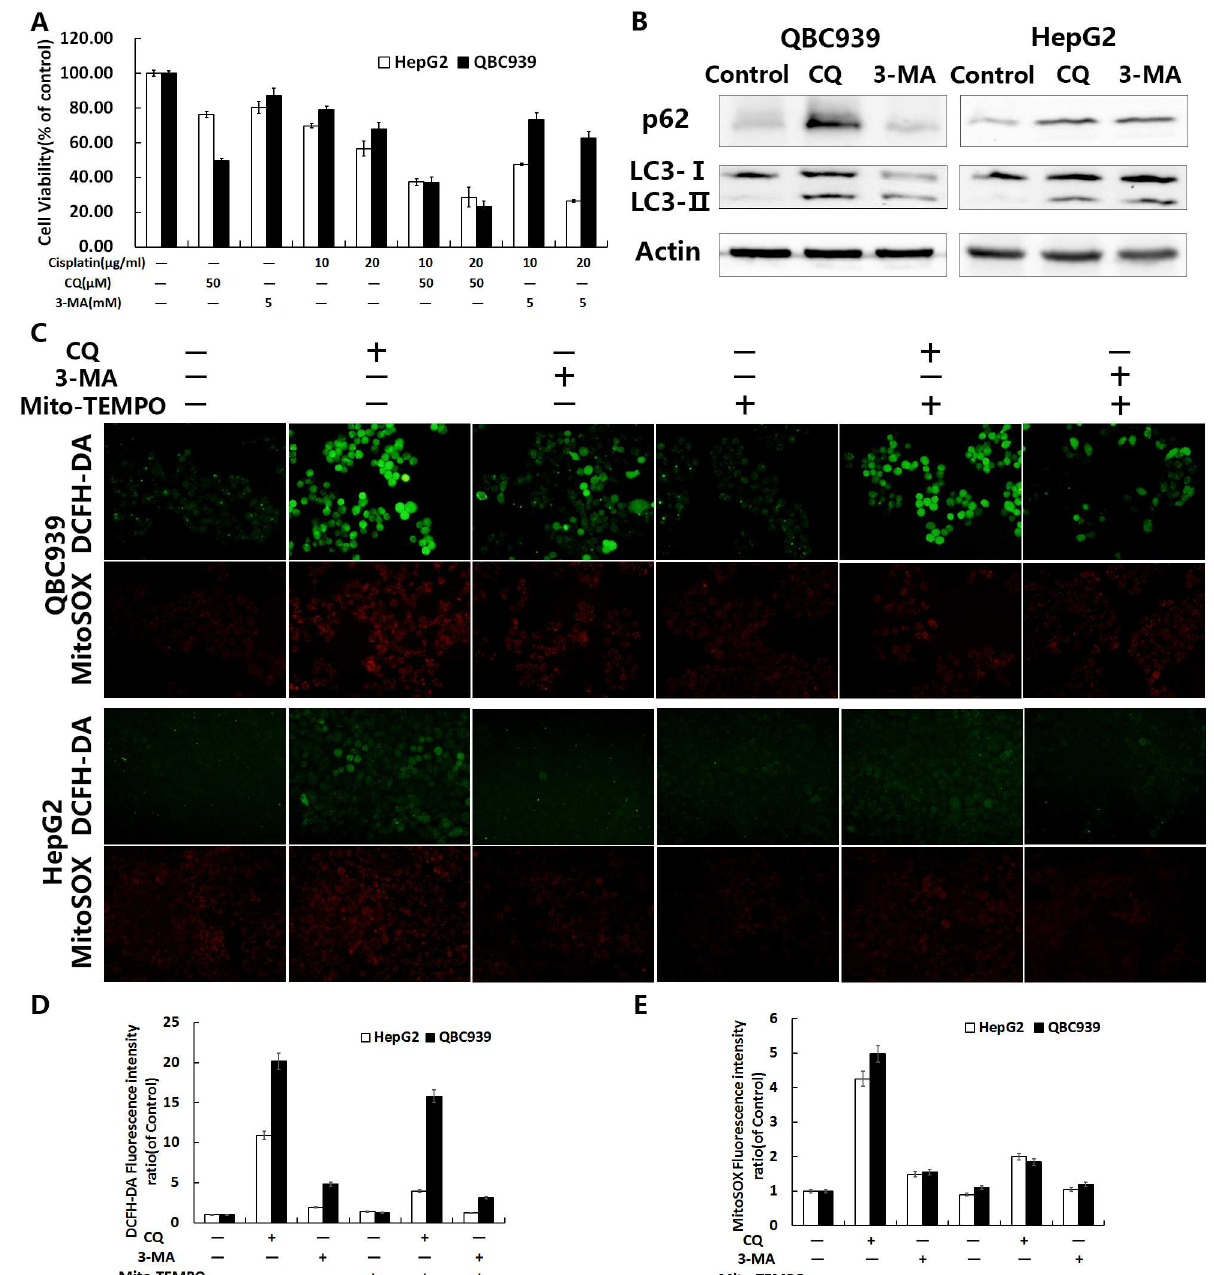
Fig 5. CQ inhibited autophagy and enhanced ROS in QBC939 cells. (A) Cells were treated with CQ (50 μ M) or 3-MA (5 mM) and/or cisplatin(10 or 20 μ g/ml) for 24 h and then cell viability was measuredby MTT assays. (B) Immunoblotanalysisof intracellular p62 and LC3-II/I in cells treated with CQ (50 μ M) or 3-MA (5 mM) for 24 h. Overall ROS and mtROS were measuredin (C) QBC939 cells and HepG2 cells treated with 100 μ M Mito-TEMPO and/or CQ (50 μ M) or 3-MA (5mM) for 12 h ( × 200). Quantitationof the cell averagefluorescence intensity of (D) DCFH-DA and (E) MitoSOX under the same treatment conditionsas in (C). All values are the mean ± SE.